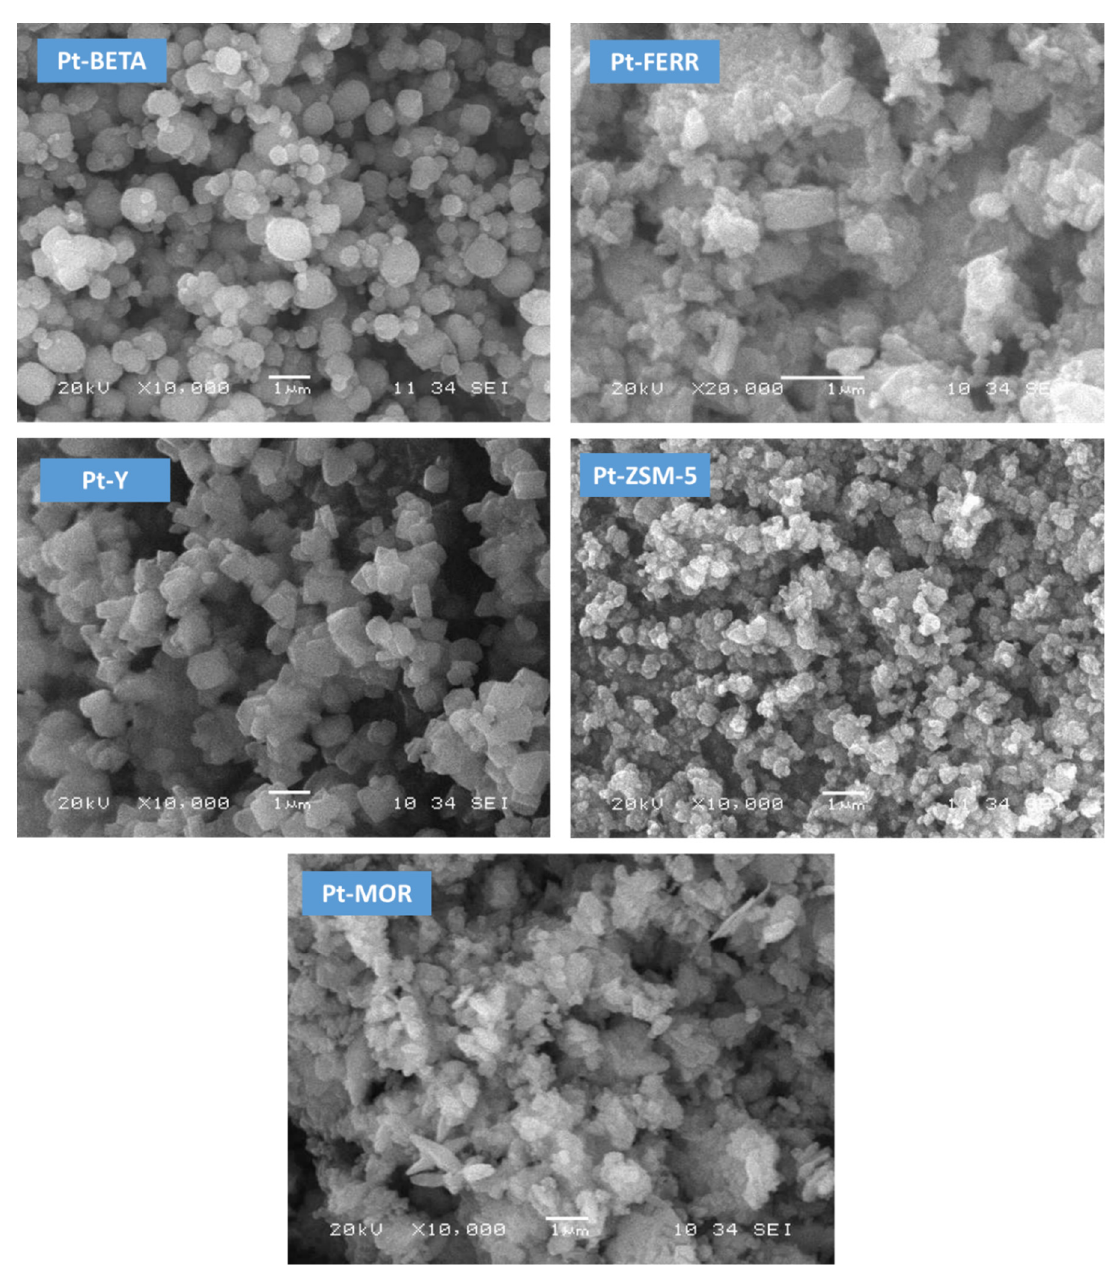
Figure 4. SEM micrographs with the same magnification for Pt-incorporated zeolite samples.